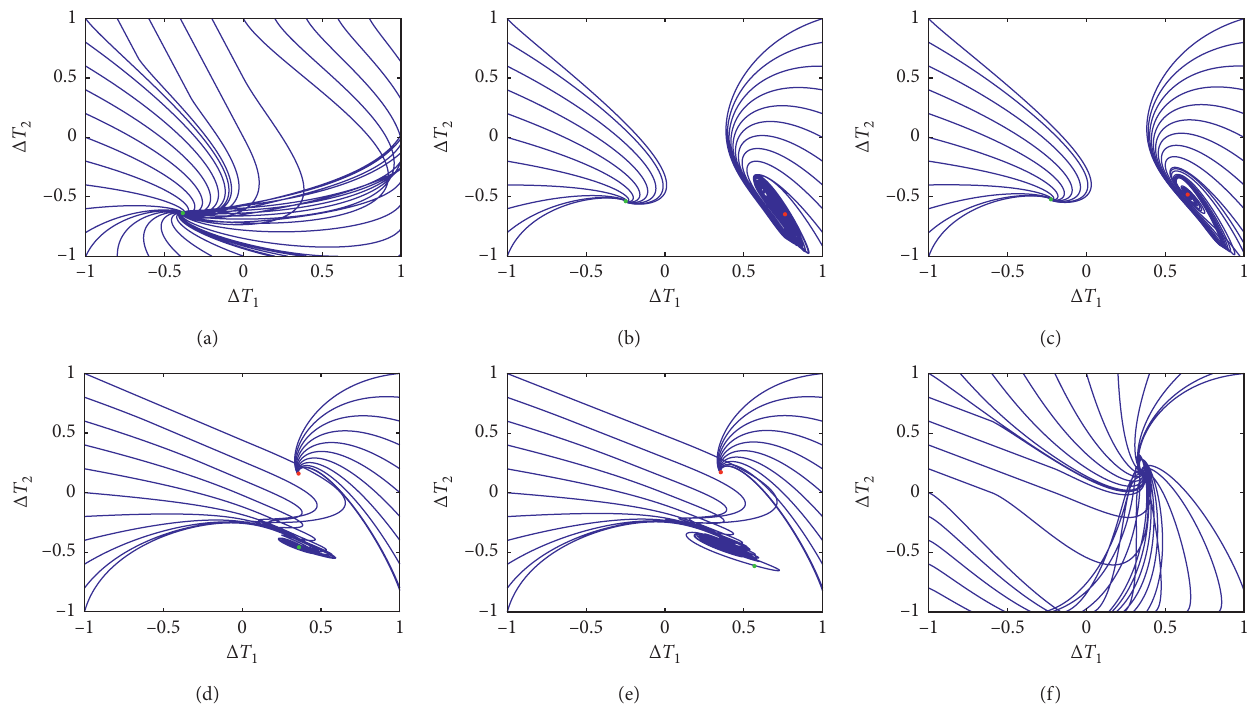
Figure 4: Phase portraits for different heat ratios. (a) k � − 2.5. (b) k � − 1.85. (c) k � − 1.75. (d) k � − 0.65. (e) k � − 0.52. (f) k � − 0.5.